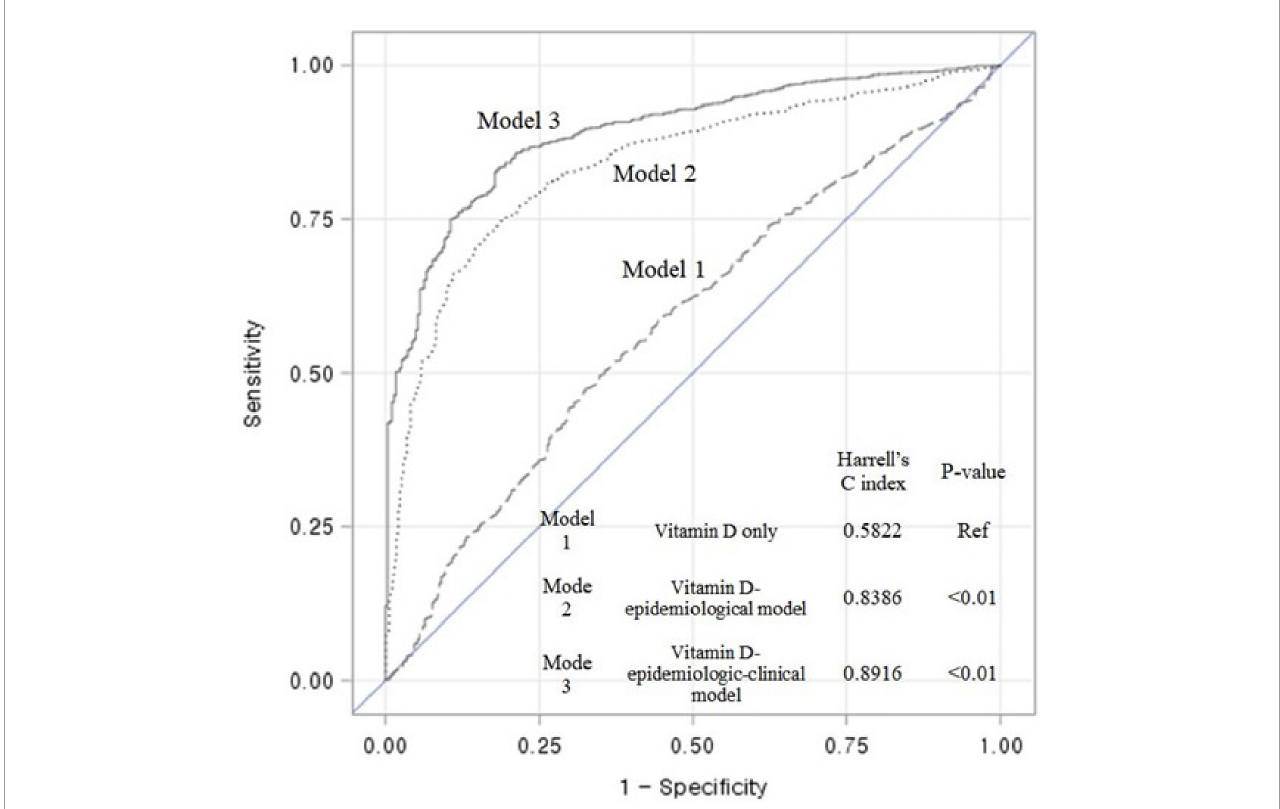
FIGURE3 Receiver operating characteristic (ROC) curves and Harrell’s C-index showing the discriminant accuracy of each model for the ability to distinguish renal events in entire cohort; Model 1 (vitamin D model): Function (Y) = β 1[25(OH)D], Function(Y) = Log (( Hazard _Exposed)/ Hazard _(Non-Exposed)); Model 2 (Vitamin D-epidemiological model): Function(Y) = β 1[25(OH)D] + β 2[Age] + β 3[Sex] + β 4[Baseline eGFR]; Model 3 (Vitamin D-epidemiologic -clinical model): Function(Y) = β 1[25(OH)D] + β 2[Age] + β 3[Sex] + β 4[Baseline eGFR] + β 5[Cause of CKD] + β 6[24-h proteinuria] + β 7[intact PTH] + β 8 [Klotho]; A full multivariable model shows the highest differential accuracy among the three models predicting the risk of renal events. The C-index of the model was significantly different from that of the vitamin D only model ( p -value < 0.01). 25(OH)D, 25-hydroxyvitamin D; eGFR, estimated glomerular